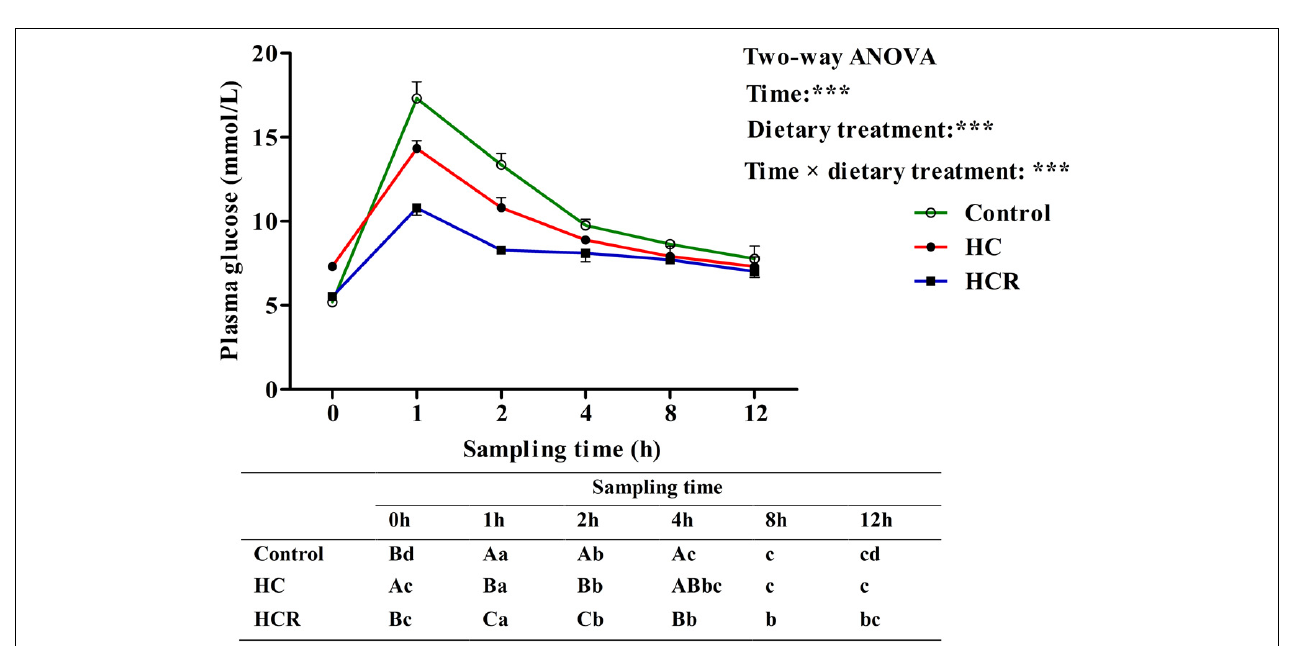
FIGURE 6 | Plasma glucose levels of blunt snout bream subjected to a glucose load after the adaption to different experimental diets. Each data represents the mean of four replicates. Different lower-case letters indicate significant differences ( P < 0.05) at different time points within each treatment, whereas different capital letters indicate significant differences ( P < 0.05) among these three treatment at each sampling point. ∗∗∗ P < 0.001. Control, diet with 30% carbohydrate level; HC, diet with 41% carbohydrate level; HCR, diet with 41% carbohydrate and 0.04%